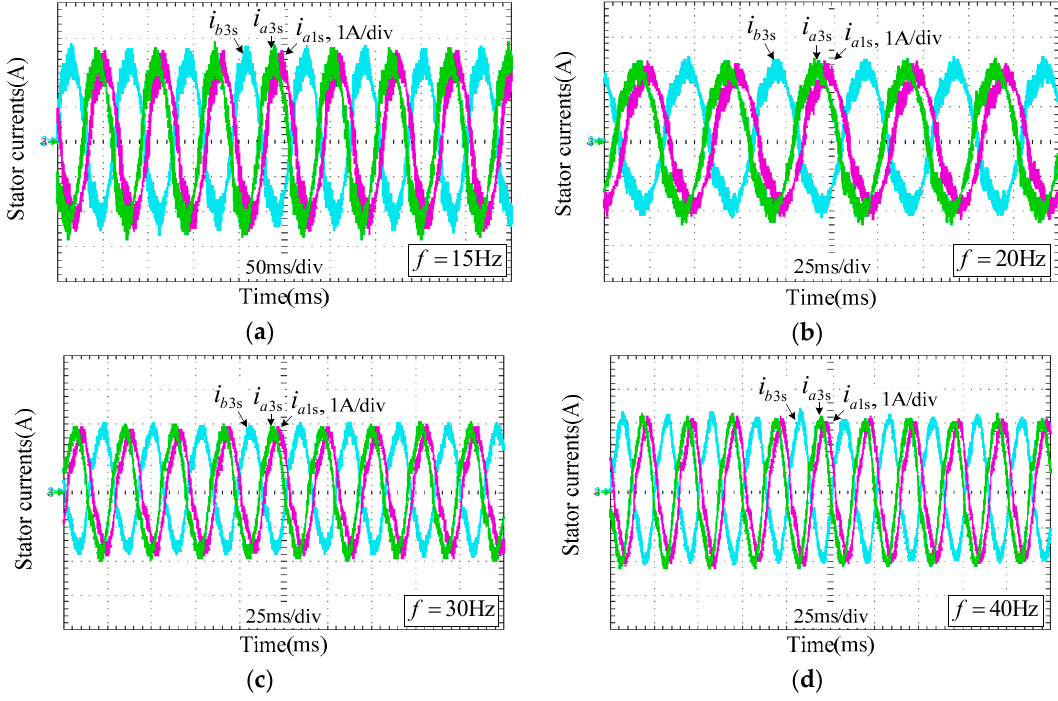
Figure 11. Stator currents during motor startup process. ( a ) At 15 Hz; ( b ) at 20 Hz; ( c ) at 30 Hz; and ( d ) at 40 Hz.